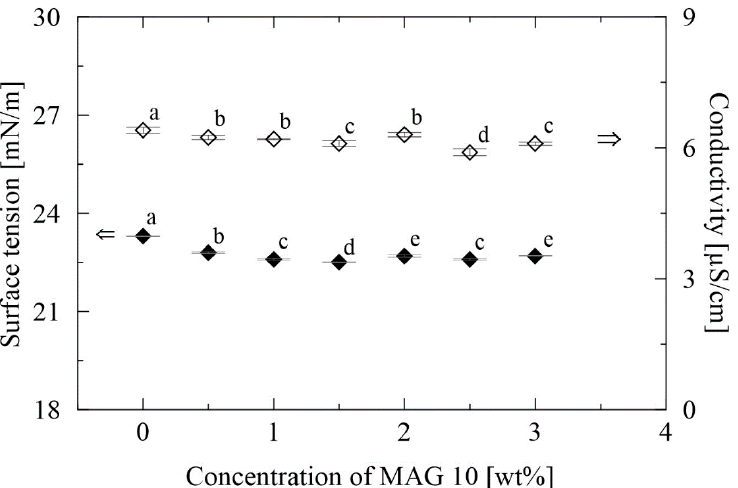
Figure 1. Surface tension and conductivity of the neat 10 wt% PVB and 10 wt% PVB/MAG 10 solutions. The various letters indicate significant differences ( p < 0.05) between the samples.